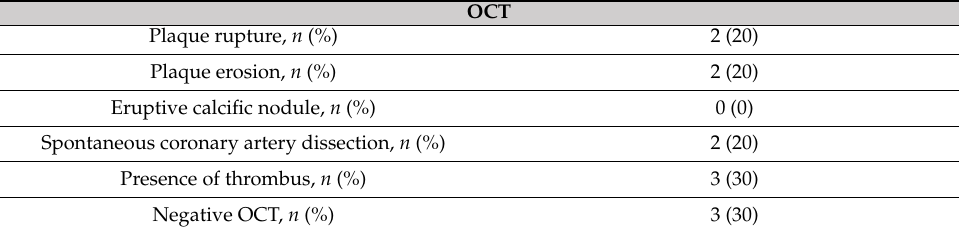
Table 2. OCT and CMR